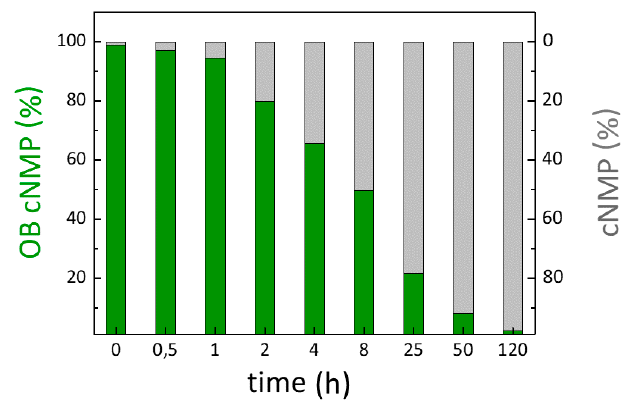
Figure 3. Course of the chemical hydrolysis of OB- N (Bu)-cAMP 12 to N (Bu)-cAMP 15 given as normalized values for each time point analyzed. Similar hydrolysis courses were measured for OB-cNMPs 10 and 13 .